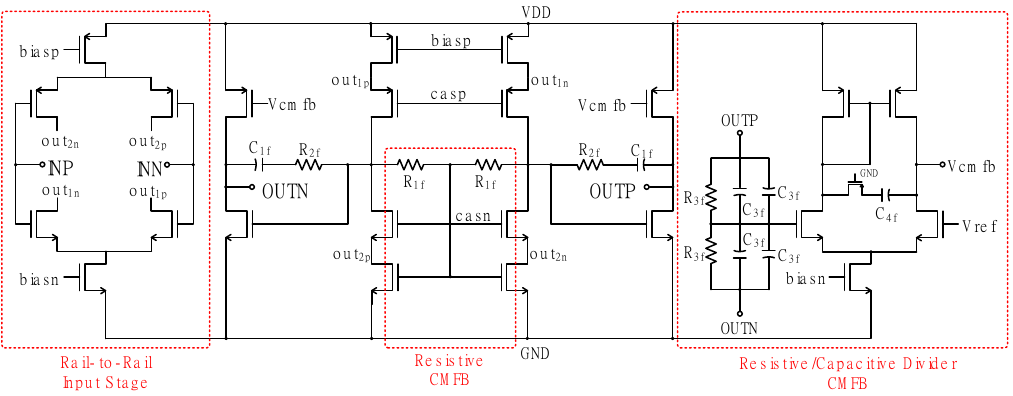
Figure 6. Fully differential amplifier with rail to rail input stage in the PGA. CMFB: common mode feedback, INN: negative input, INP: positive input, OUTN: negative output, OUTP: positive output.